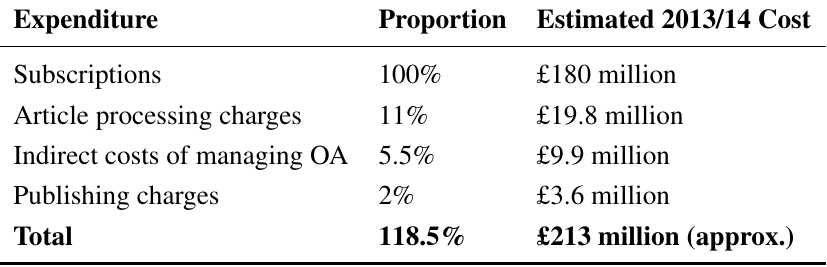
Table 2. Breakdown of the estimated total cost of publication by proportion of subscription